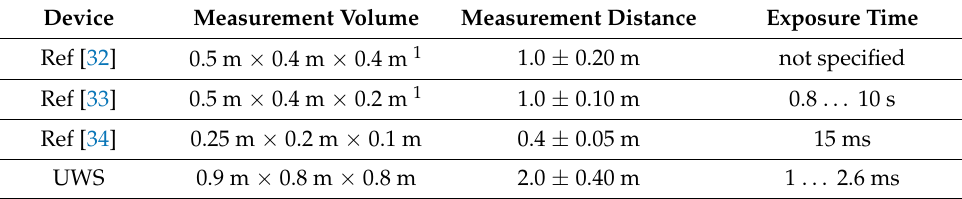
Table 4. Parameters of the 3D scanner compared previous devices based on structured illumination.